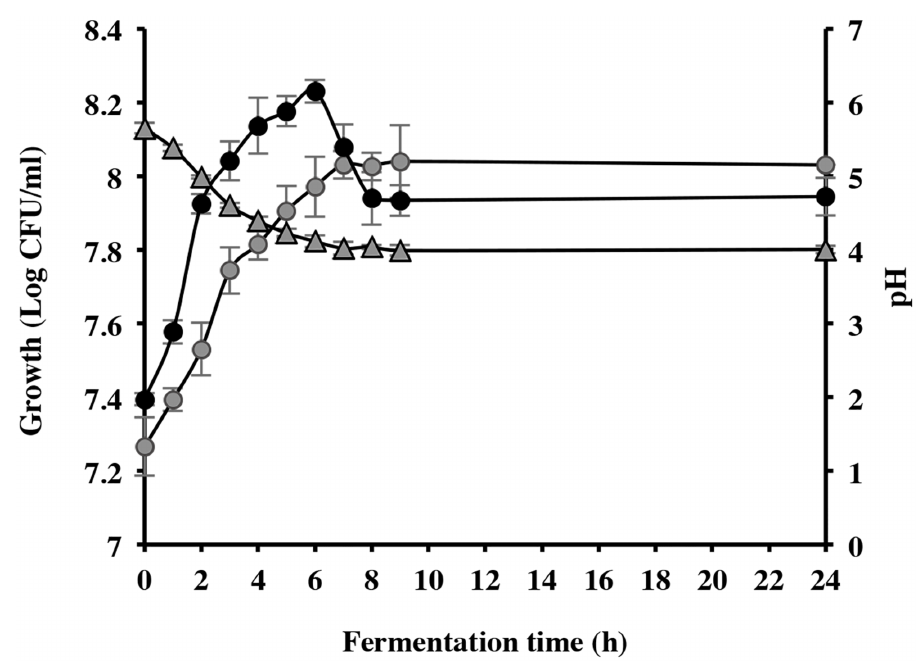
Fig 3. L . reuteri CRL1098 growth in PETG medium under controlled and uncontrolled pH. (black circle) pH- controlled culture (gray circle) pH-uncontrolled culture; (gray triangle) pH.